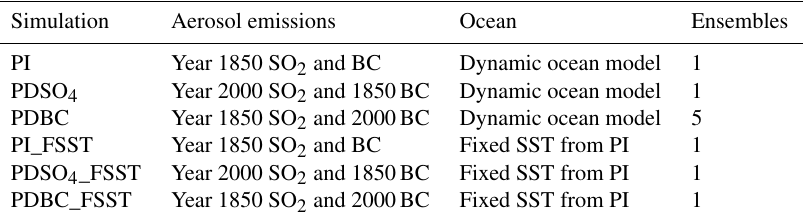
Table 1. Simulation